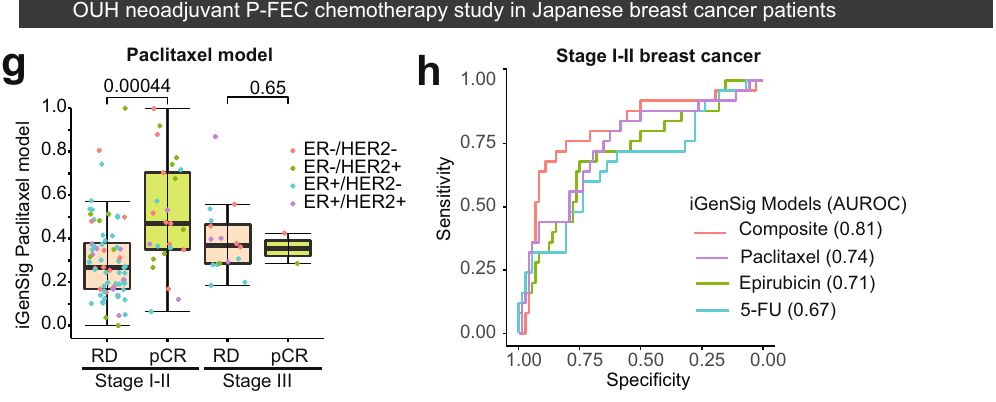
OUH neoadjuvant P-FEC chemotherapy study in Japanese breast cancer